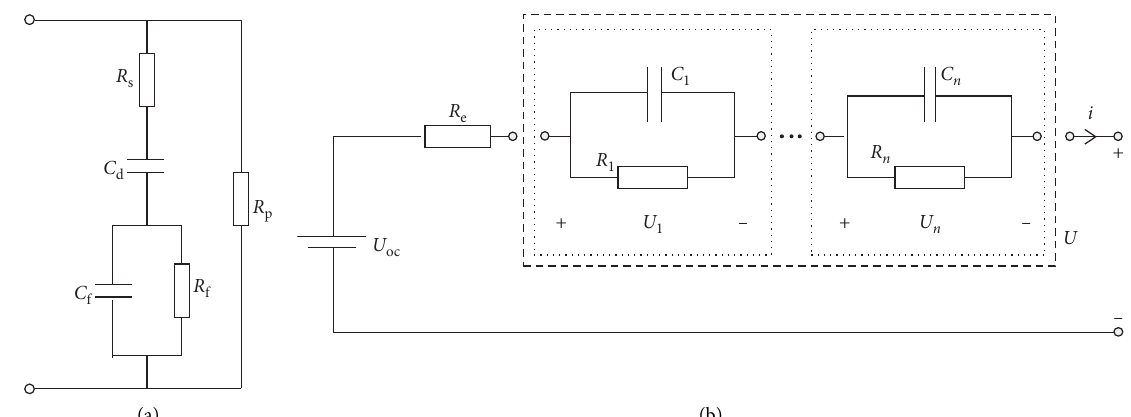
Figure 3: Model of supercapacitor and lithium battery. (a) Supercapacitor equivalent circuit model; (b) nRC equivalent circuit model of lithium battery.